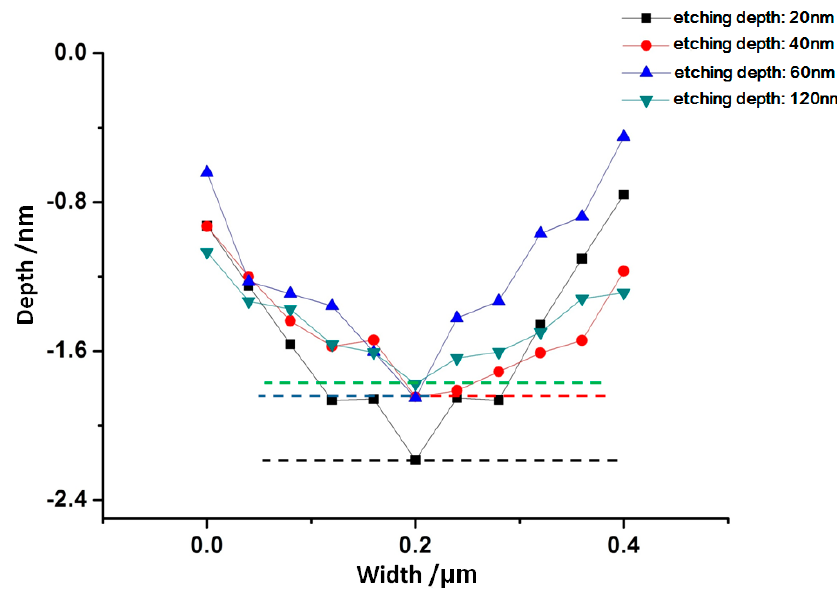
Figure 10. Size evolution of pits in SAE preprocessing.